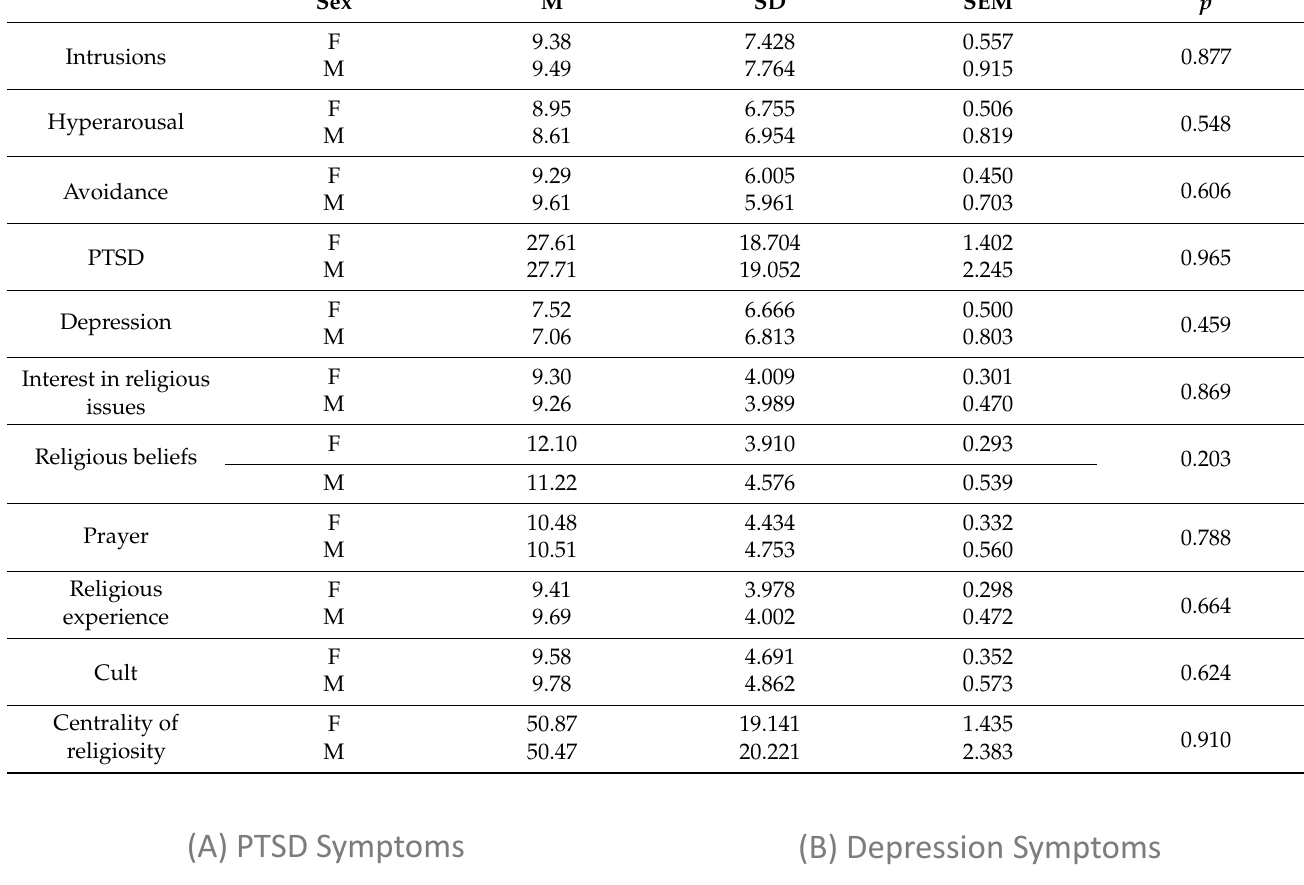
Table 2. Descriptive statistics and the significance of differences in the intensity of studied variables in men and women.